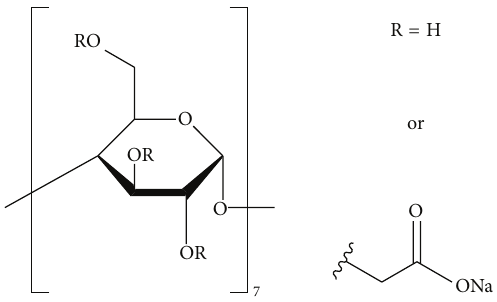
Figure 1: Molecular structure of carboxymethyl- 𝛽 -cyclodextrin sodium salt (CM- 𝛽 -CD).